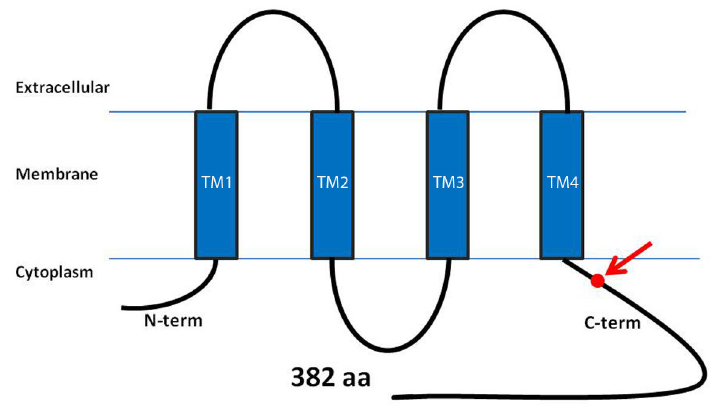
Figure 4. Domain structure of CONNEXIN 43. The CX43 protein consists of an intracellular amino acid domain (AT), four transmembrane domains (TM), two extracellular loops and one intracellular loop. The novel CMD mutation is indicated as a red dot in the carboxyl-terminal domain